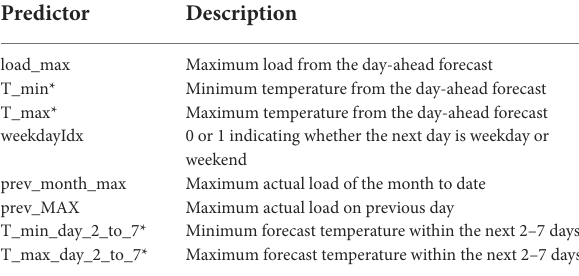
TABLE 2 Predictors for the peak day